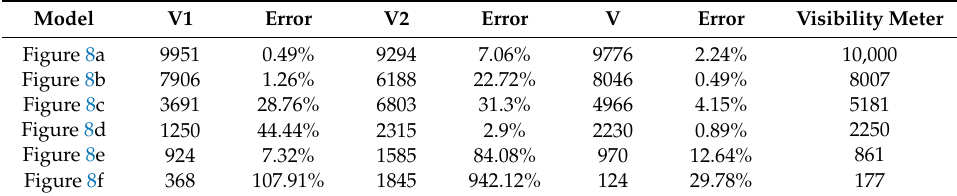
Table 4. Estimated results of the images in Figure 8.